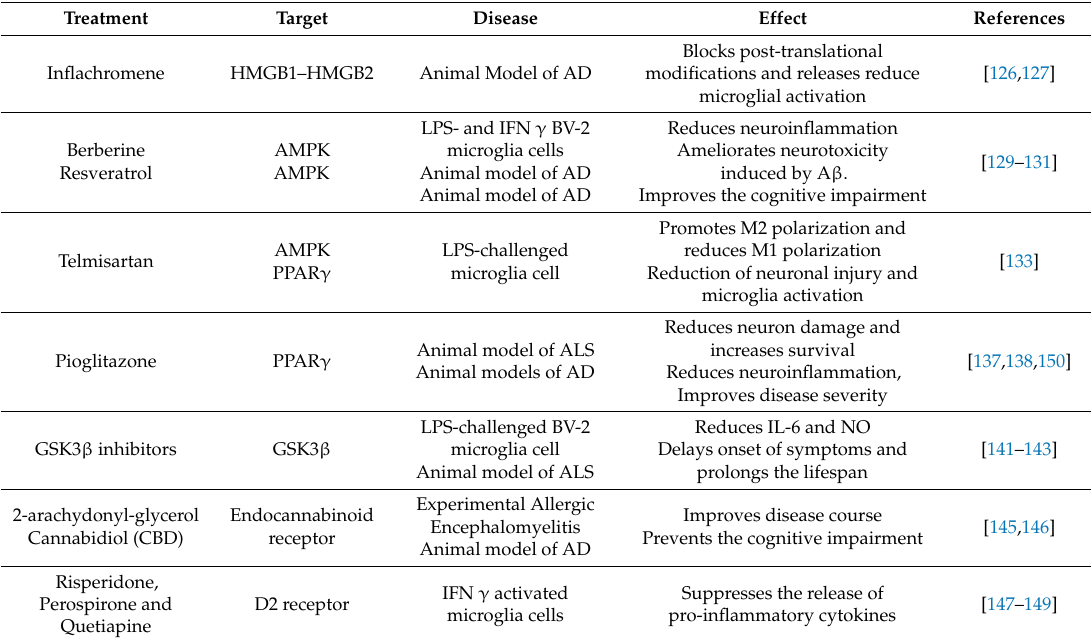
Table 1. Myeloid-targeted